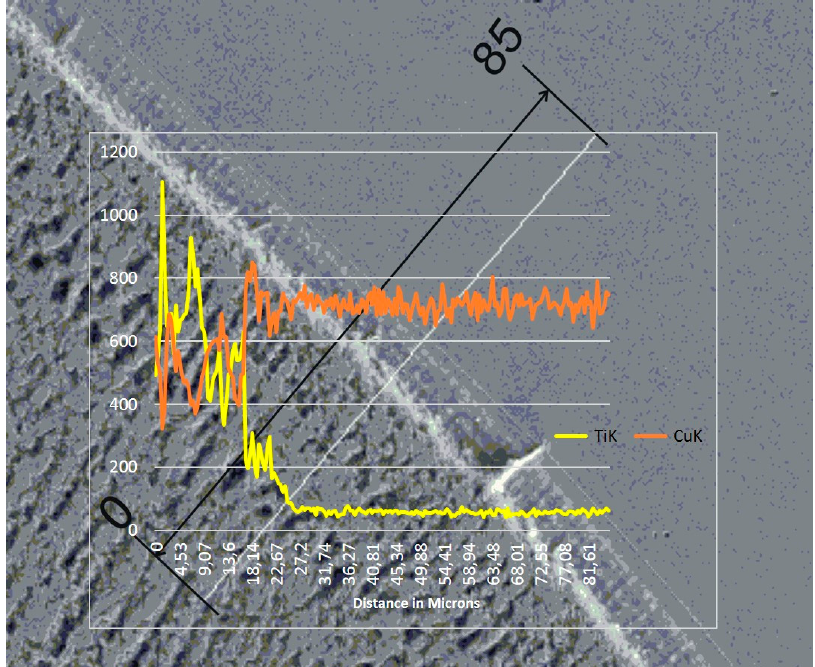
from the selected area: Ti 6.58% wt., Cu 93.42% wt.